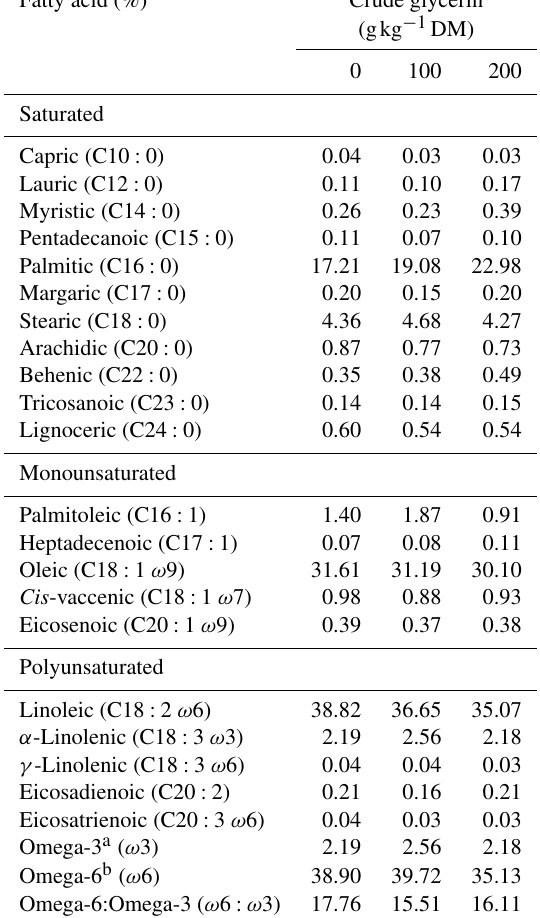
Table 2. Percentage composition of fatty acids in